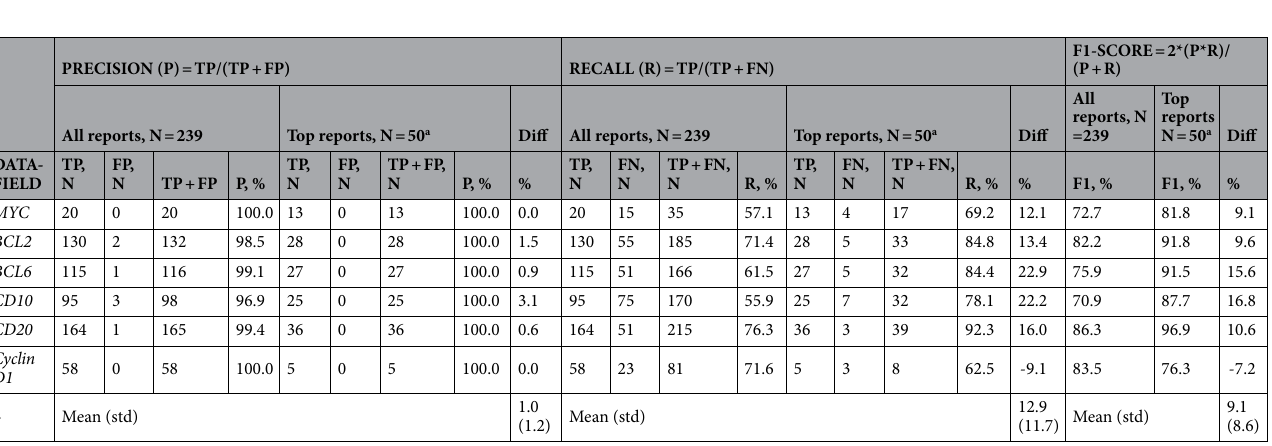
Table 2. Comparison of ARGO performance in the whole vs. the top 50 reports a . ARGO: Automatic Record Generator for Onco-hematology, TP: True Positive, FP: False Positive, FN: False Negative, CD: Cluster of Differentiation, Diff: difference, std: standard deviation. a Top 50 reports (internal series) with the highest optical